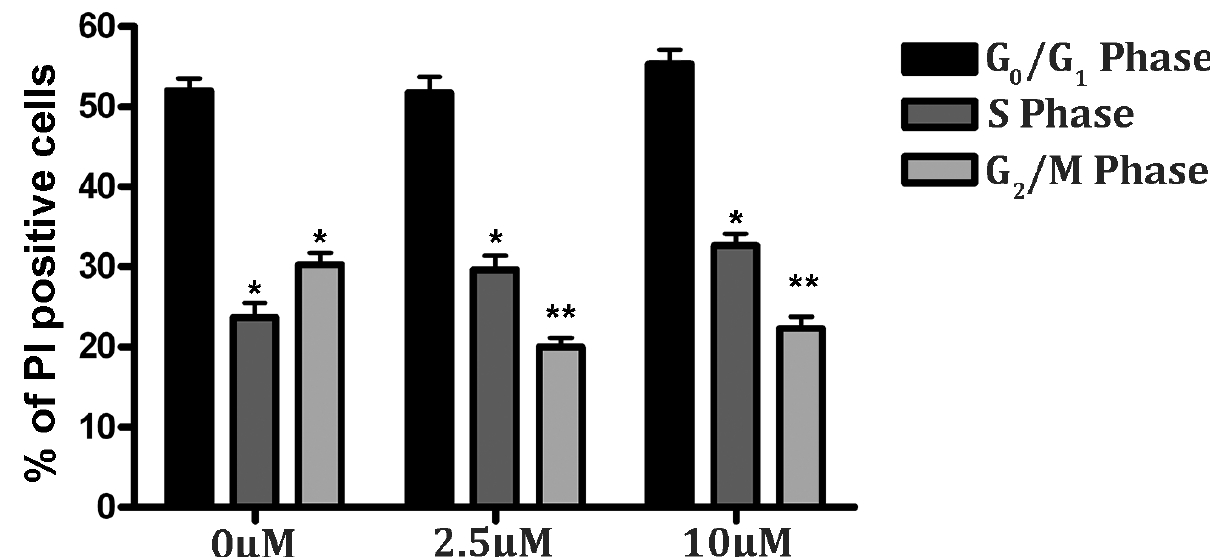
Figure 5. RSV improves cell cycle progression in PC12 cells under hypoxic stress . Cells were treated with RSV for 24 h prior to hypoxic treatment. Cells were cultured in fresh media and harvested post-24 h. Next, cells were fixed in ethanol and stained with PI for a cell cycle analysis by flow cytometry. Results of the cell cycle analysis were represented in percentage values (* p < 0.05, ** p < 0.01). The representative results of three independent experiments are shown in the bar graph. Data are represented as means ± SD of triplicate experiments.